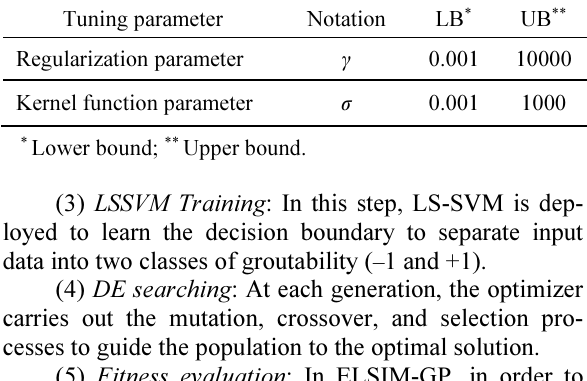
Table 4. Ranges of ELSIM-GP’s tuning parameters Tuning parameter